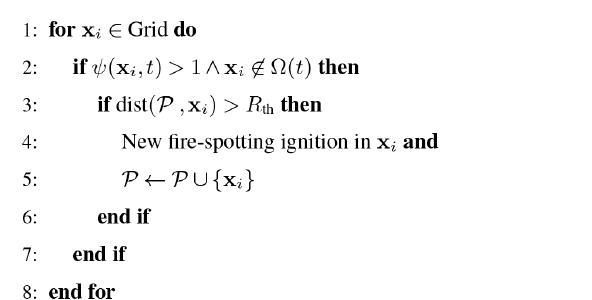
Algorithm 1 algorithm for point-wise ignition due to